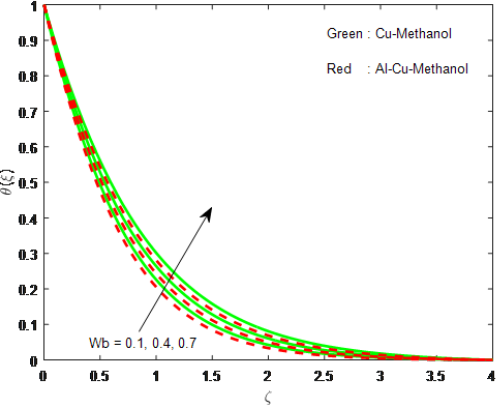
Fig. 9: Impression of wb on g (cid:48) ( ξ )